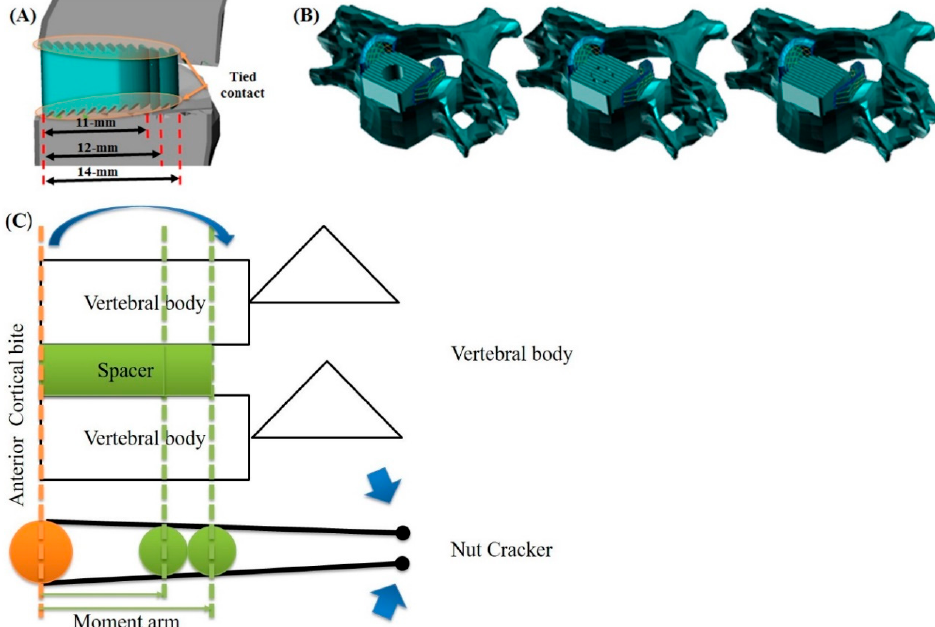
Figure 1. Design of allograft spacers. Length and position of allograft spacers. ( A ) Anterior cortical